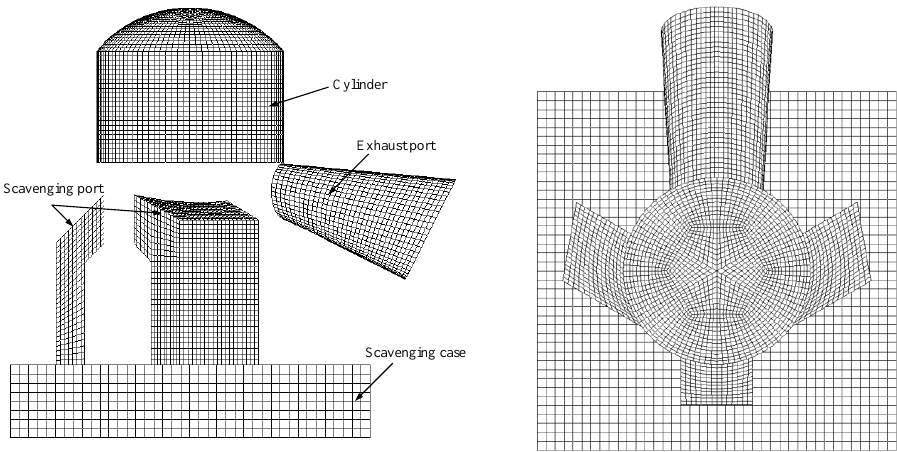
Figure 8. Computational mesh for the CFD scavenging model.